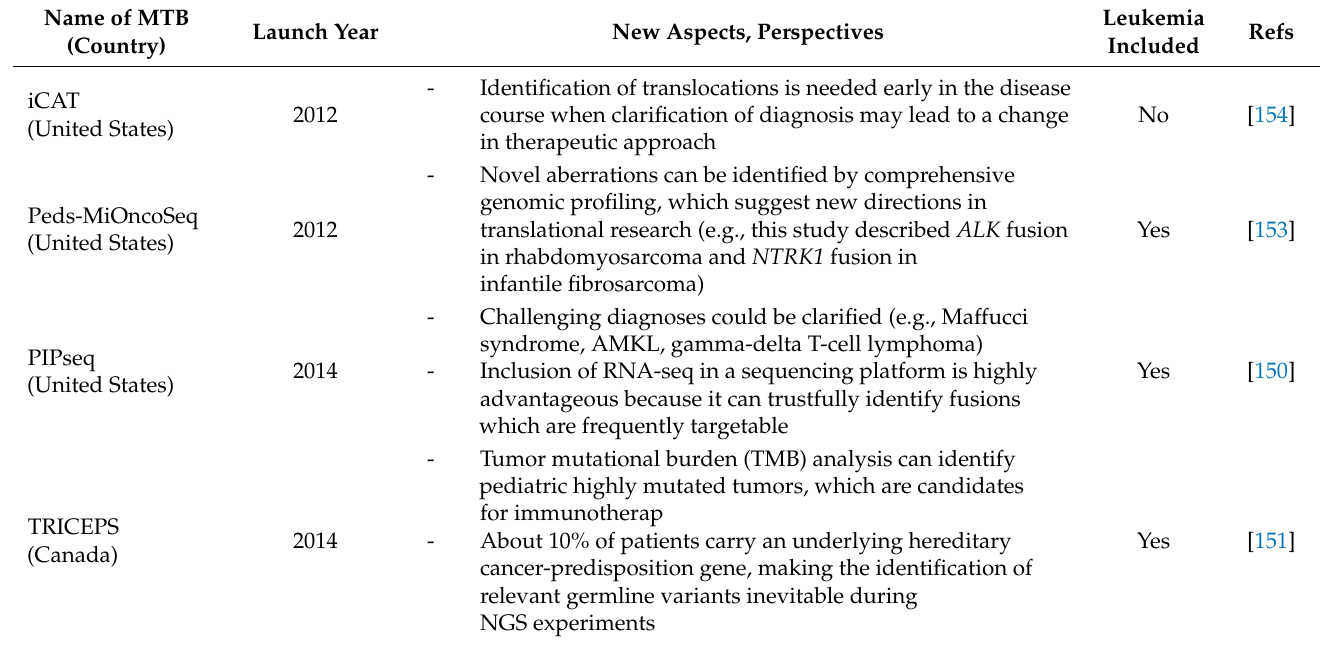
Figure 2. Current niche and estimated efficacy of small-molecule targeted agents in the clinical management of pediatric acute leukemia. ( a ) Proportion of patients with pediatric acute leukemia who are eligible for targeted drugs with on-label indications in acute leukemia based on genetic features. ( b ) Estimated proportion of children with acute leukemia who are expected to benefit from the currently available, on-label small-molecule targeted therapies based on average overall response rates. Table 3. Some examples of tumor genome profiling and pediatric molecular tumor board (MTB) initiatives in hematological or solid tumor